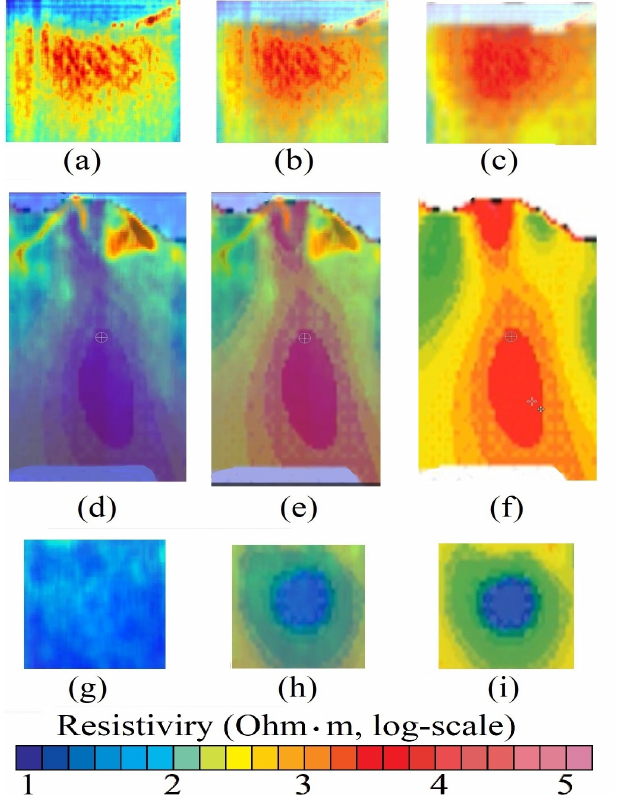
Figure 25. Overlay of SAR Doppler tomography with magnetotelluric tomography (particulars). ( a , d , g ) Radar tomographic results. ( b , e , h ) Radar tomographic results 50% overlapped to magnetotel- luric tomographic results. ( c , f , i ) Magnetotelluric tomographic results. The symbol · represents the scalar